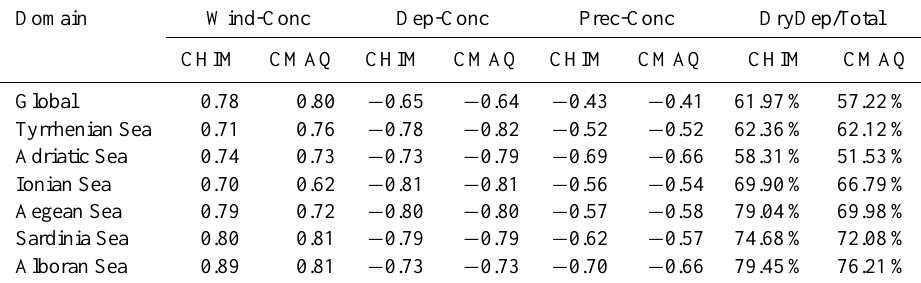
Table 3. Correlation of the sea-salt concentration (Conc) from CHIMERE and CMAQ models with different variables over small domains within the Mediterranean sea (wind speed, Wind; total deposition, Dep; and precipitation, Prec). Also, the dry deposition contribution over total deposition is shown (DryDep/Total).